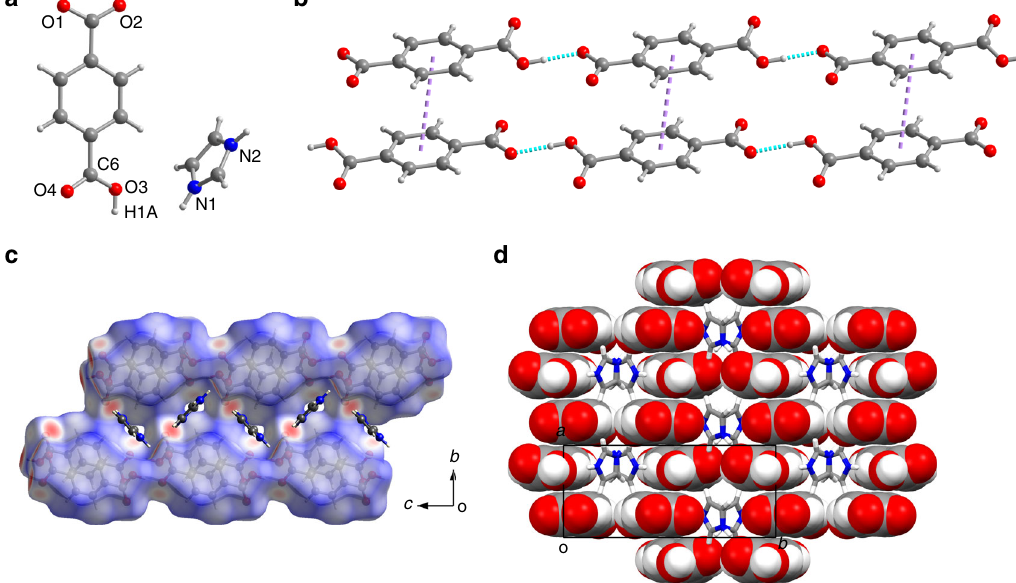
Fig. 3 Crystal structure of 1-d 0 at 293 K. a Asymmetric unit. b Intermolecular interactions among TPA monoanions. Purple and cyan dotted lines represent the π ··· π and H-bonding interactions, respectively. c Cross-sectional view of the Hirshfeld surface of the anionic host channel containing the Im cations. The red, white, and blue regions of the surfaces correspond to the positive (close contact), neutral, and negative isoenergies, respectively. d Front view of the